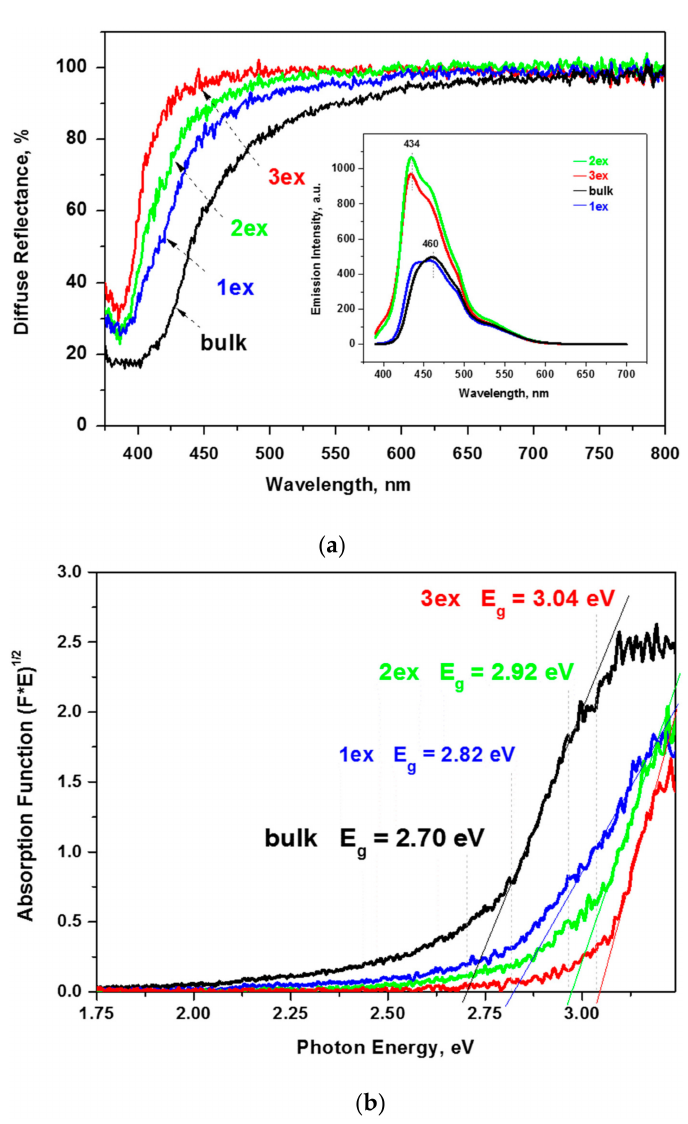
Figure 6. Reflectance spectra and photoluminescence (PL) emission spectra (inset) of the bulk and exfoliated g-C 3 N 4 ( a ) and the respective absorption function plots ( b